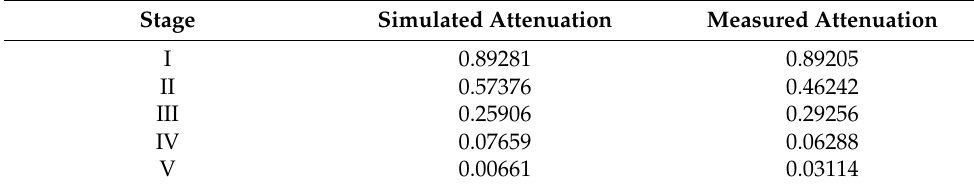
Table 2. Attenuation for all five stages using simulation and